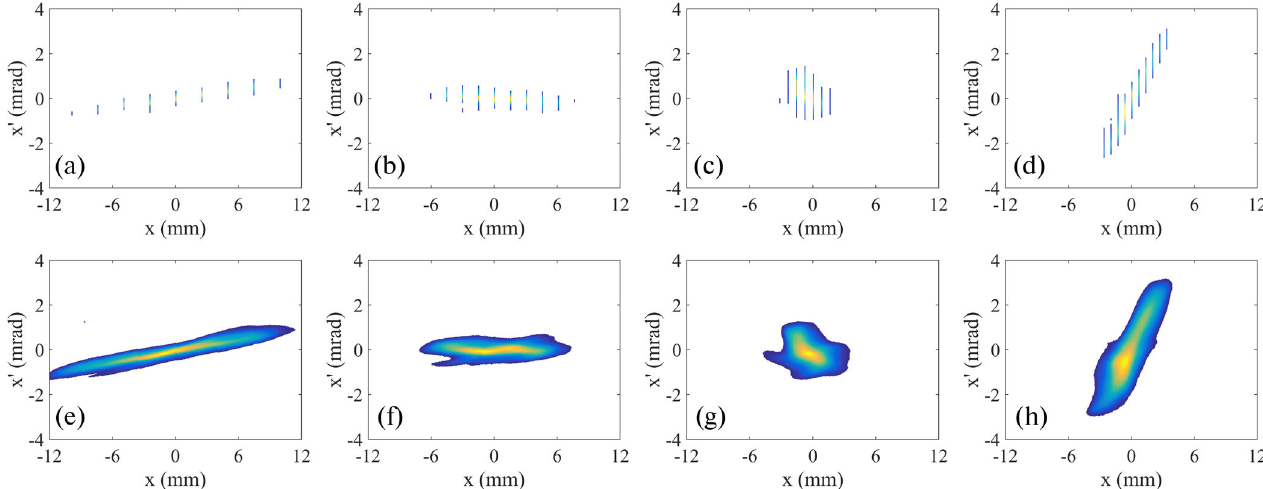
FIG. 5. Comparison of projection-based and slit-scan diagnostics. The top and bottom rows show experimentally measured TPSs using the slit-scan and projection methods, respectively. Slit scan measured the second moments of the horizontally sliced beam, and the projection beam line projects this sliced beam for the measurement. From left to right, the columns correspond to quad A gradient settings of 0.28, 0.36, 0.50, and 0 . 61 T = m. The quad B gradient is − 0 . 41 T =